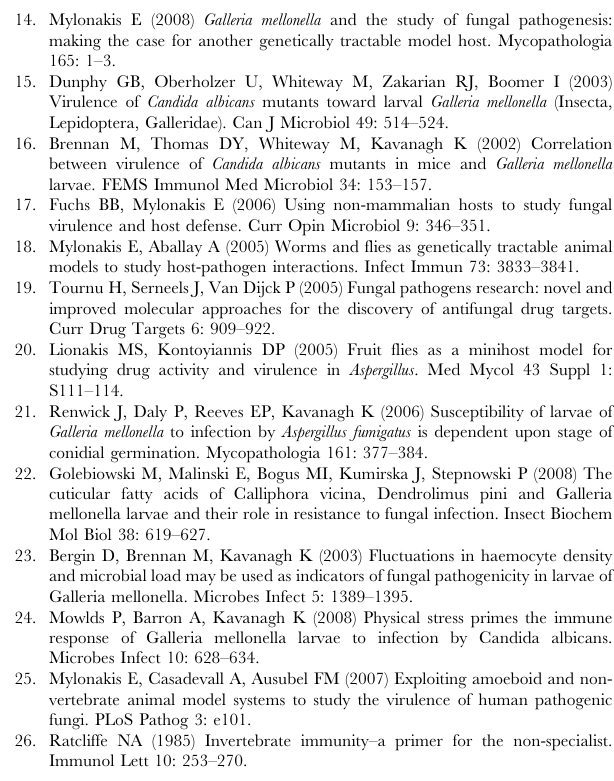
Figure S1 Locations of primers used for PCR screening within the six-gene cluster for melanin biosynthesis.